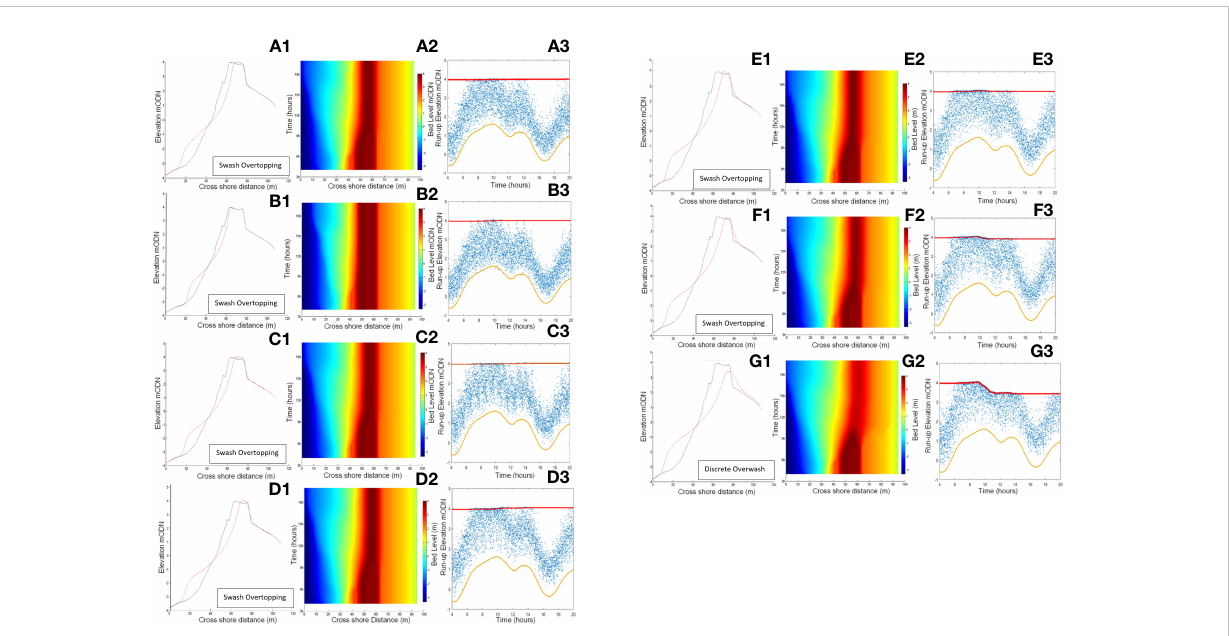
FIGURE 6 Comparison of pro fi le change and runup at Pro fi le 2 from sea states with bimodal waves containing different swell percentages. (A) 0%, 10% (B) , 25% (C) , 35% (D) , 40% (E) , 50% (F) , 75% (G) . Hs=3.64m, Tp=10s, SWL=1.52m. - Red Line- Maximum Crest Elevation, Orange Line - SWL, - Blue cross – Maximum wave